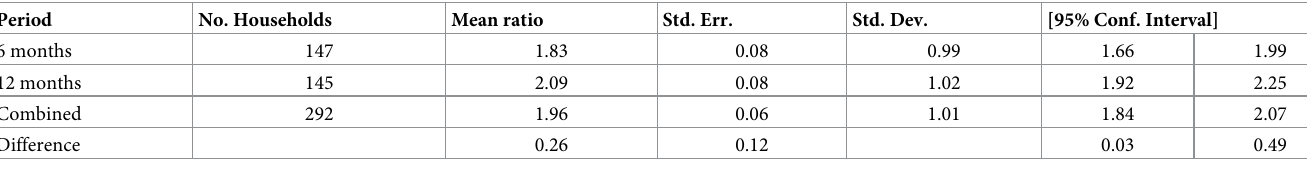
Table 2. Ratio of people per net in households (t-test). Period No. Households Mean ratio Std. Err. Std.